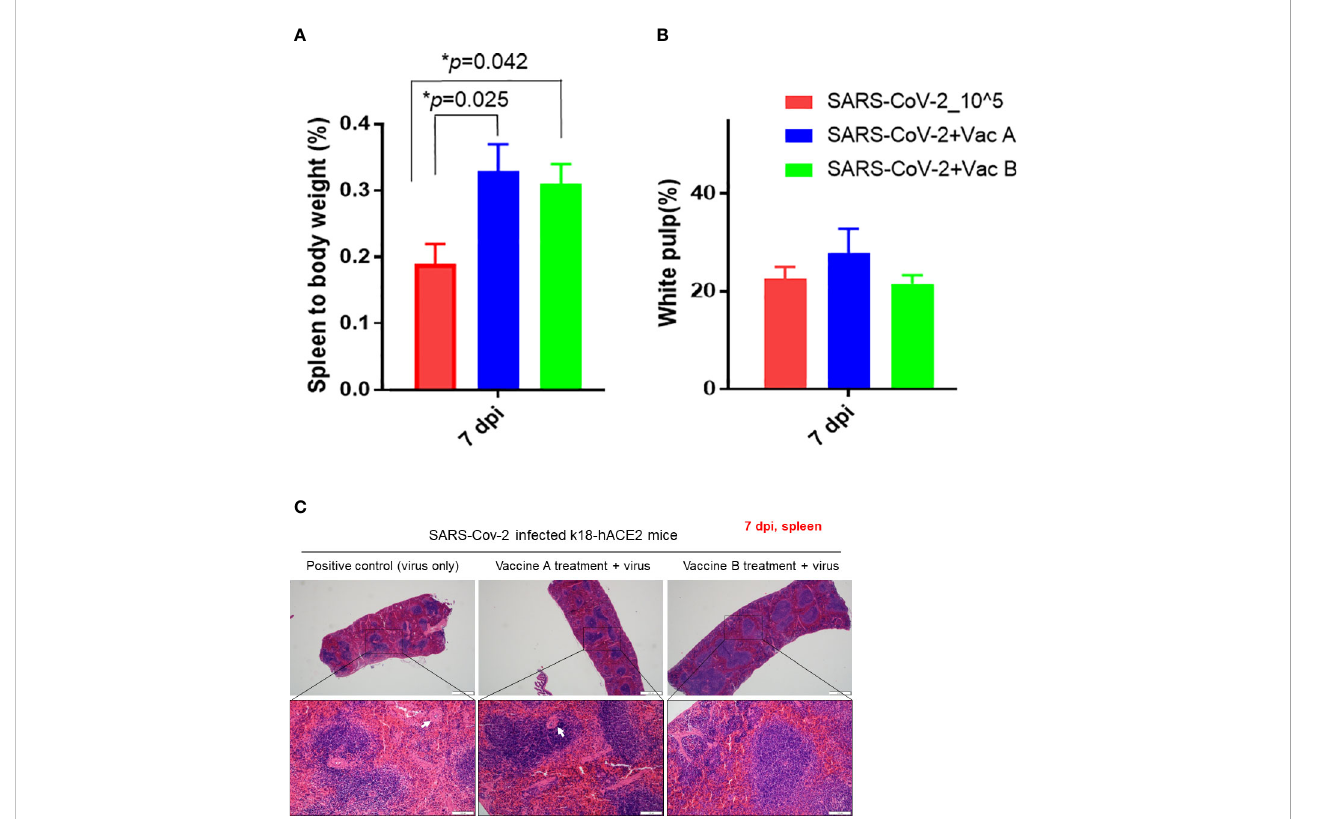
FIGURE 5 Pathological changes of K18-hACE2 TG mouse spleens after SARS-CoV-2 infection with and without vaccines. (A) Spleen to body weight %. (B) White pulp atrophy %. (C) Histopathology of mouse spleens after being paraf fi n-embedded and processed for hematoxylin – eosin (H&E) staining. Splenic white pulp atrophy is indicated in white arrows. Scale bars 50 µm (upper line) and100 µm (lower line). *p <